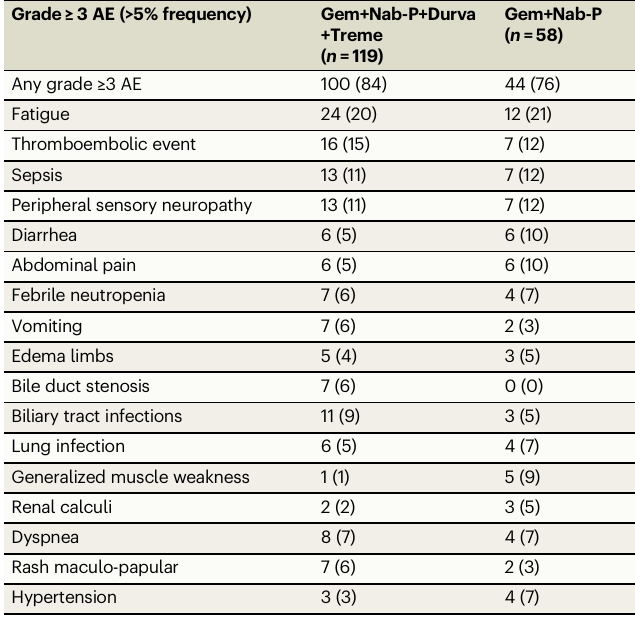
Table 2 | List of grade ≥ 3 adverse events on